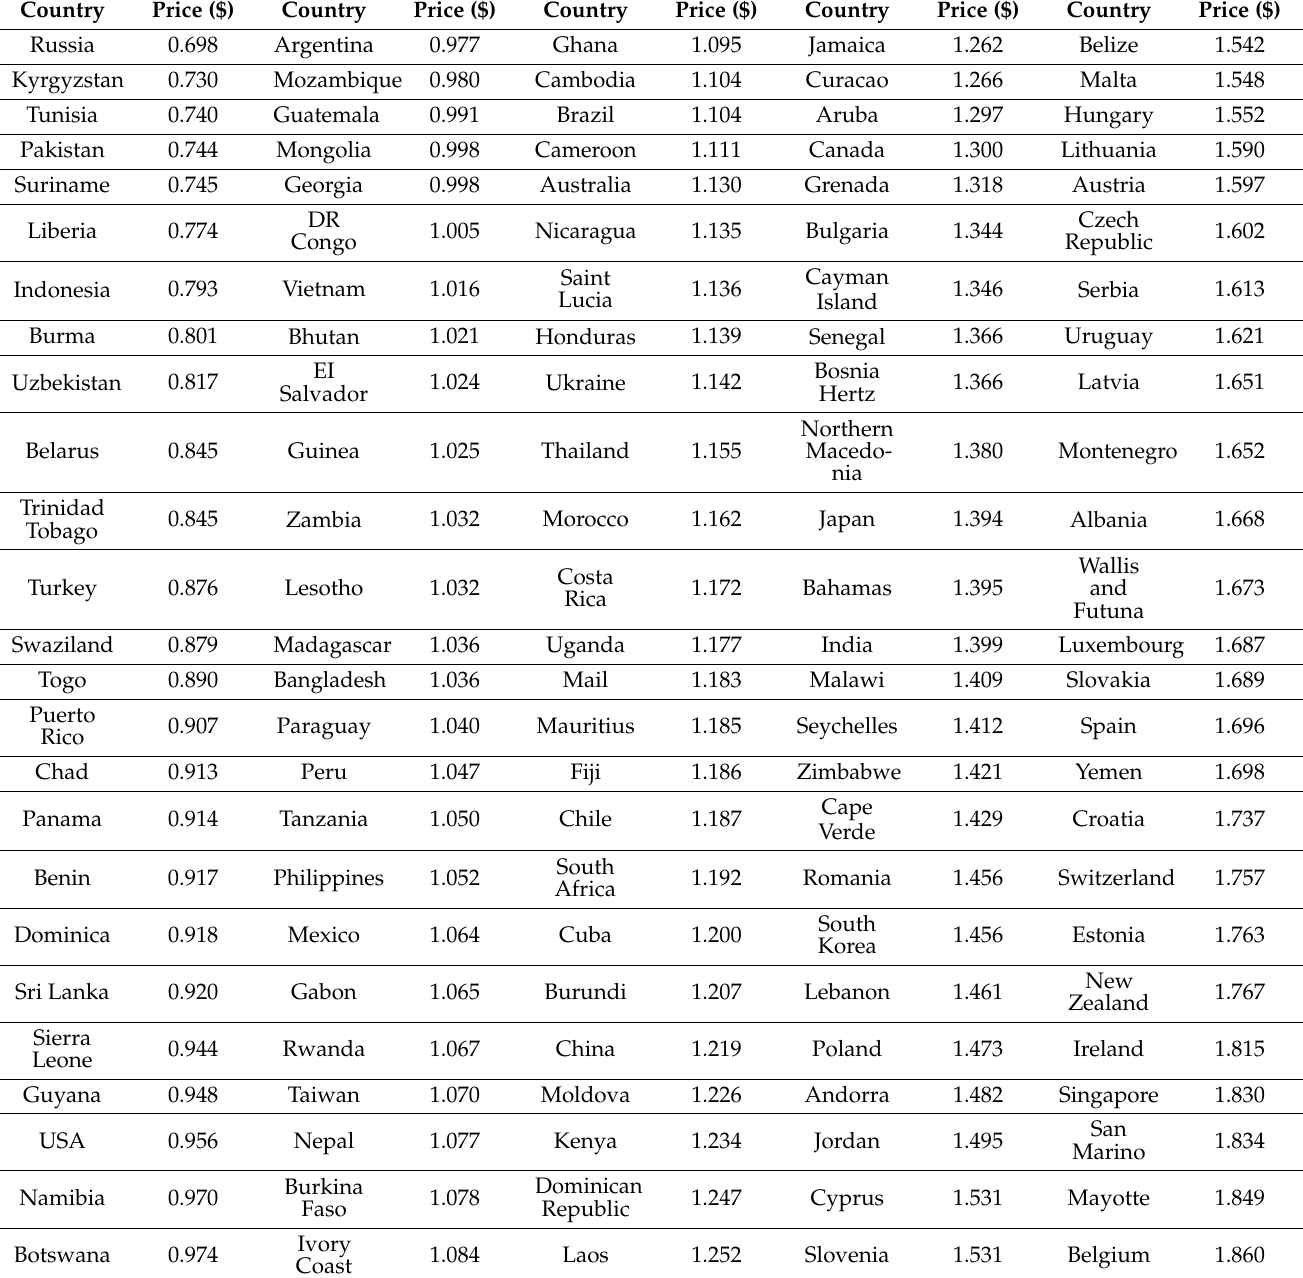
Table 1. Diesel fuel prices in selected countries